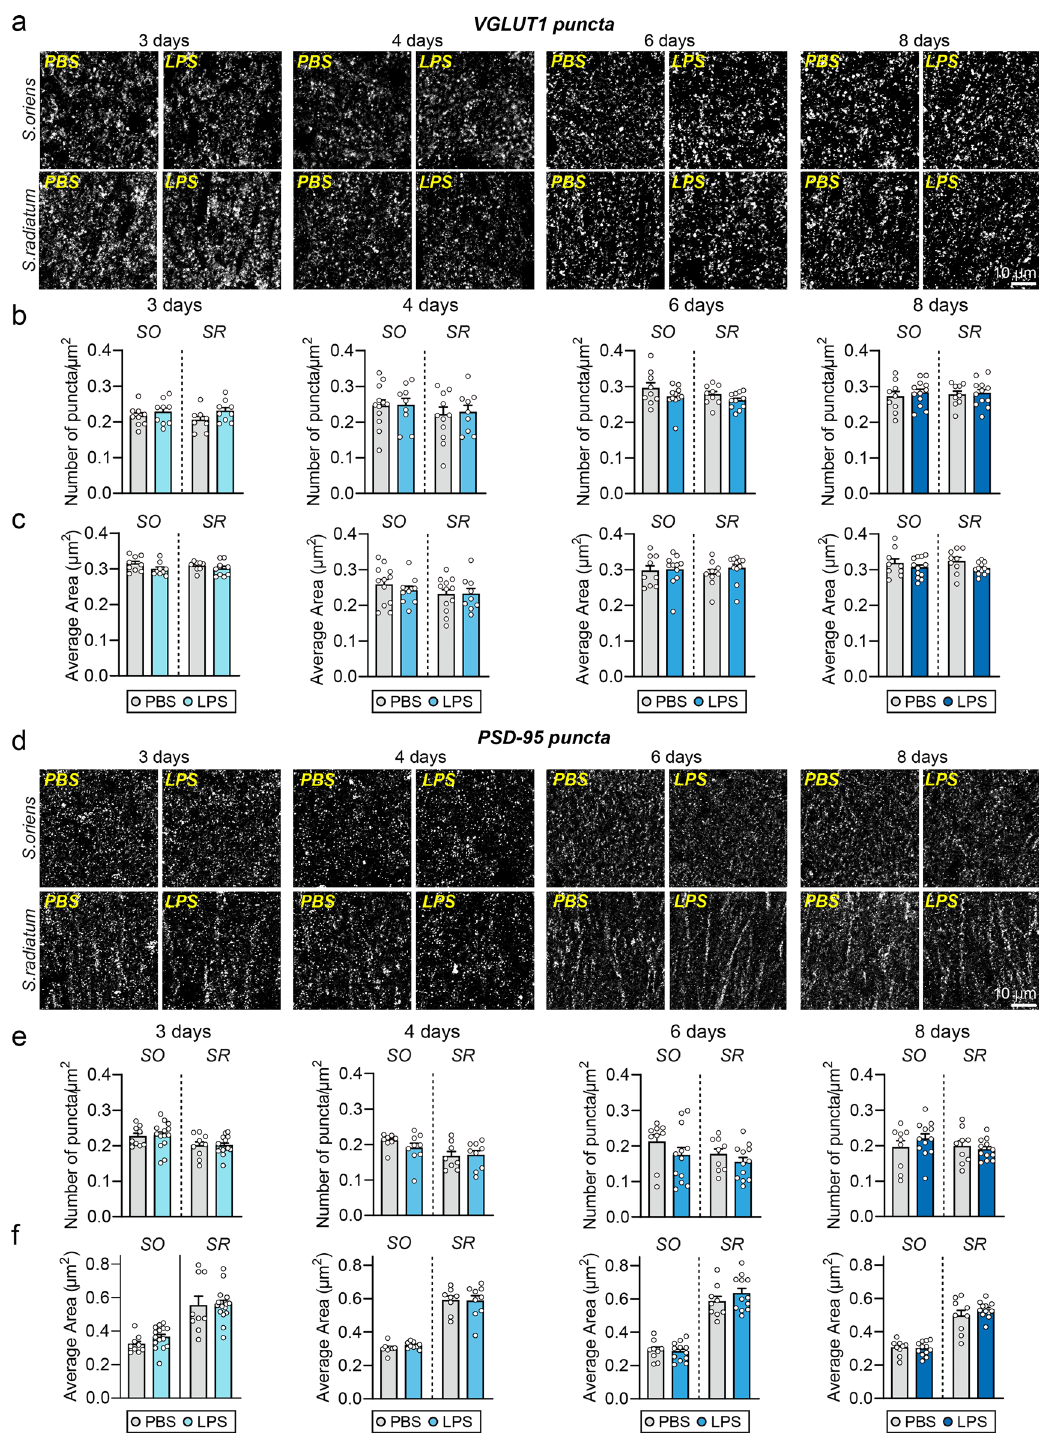
Figure 3. LPS-induced neuroinflammation has no effect on the maintenance of excitatory synapses in the hippocampus of adult mice. ( a , d ) Representative images of hippocampal CA1 SO , and SR layers 3, 4, 6, and 8 d after LPS administration in mice, followed by immunostaining for the excitatory synapse marker VGLUT1 ( a ) or PSD-95 ( d ). Scale bar: 10 μm (applies to all images). ( b , c , e , f ) Quantification of the density and area of VGLUT1-positive ( b , c ) or PSD-95–positive ( e , f ) synaptic puncta. Data are means ± SEMs (n = 8–15 slices from 3 to 5 mice per